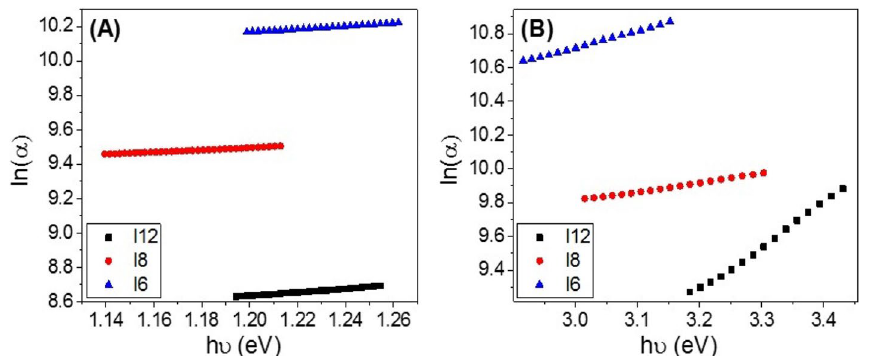
Figure 8. Calculation of Urbach energy ( A ) Eu 1 and ( B ) Eu 2 for I-6, I-8 , and I-12 in liquid crystal phase designed at 140